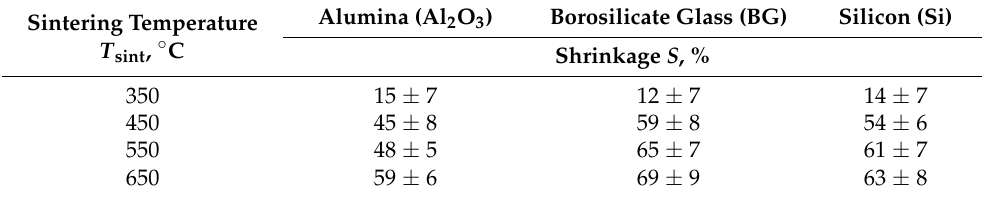
Table 2. Shrinkage of printed lines as a function of sintering temperature on various